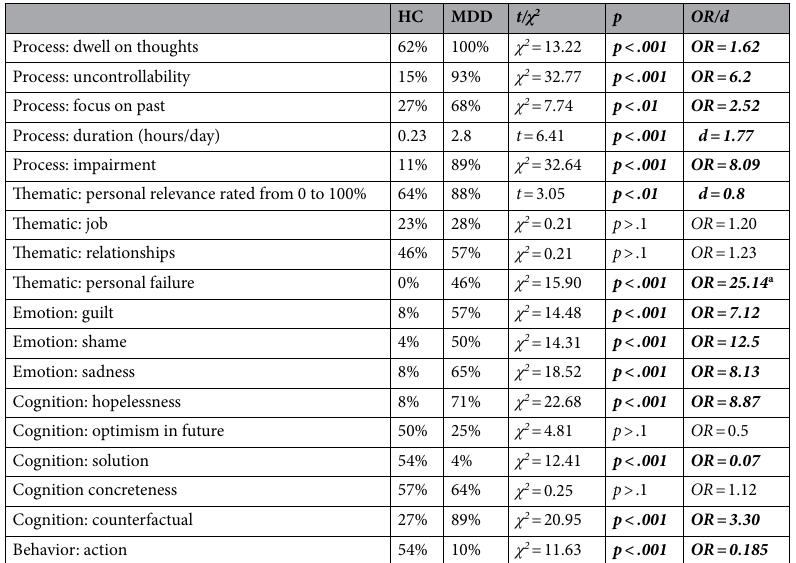
Table 3. Results of the qualitative interview of depressed subjects and healthy controls on their ruminative tendencies. Significant p-values and effect sizes are depicted in bold for reasons of clarity. All p-values are calculated as Fisher’s exact tests. a Computed with Haldane-Anscombe